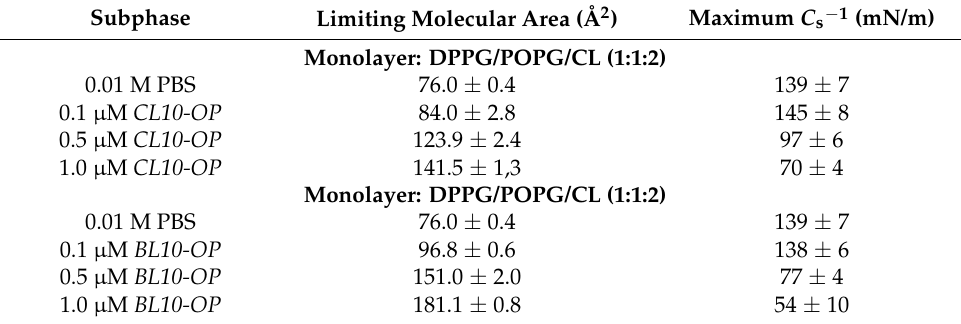
Table 2. Characteristic parameters of Langmuir monolayers. Subphase Limiting Molecular Area (Å 2